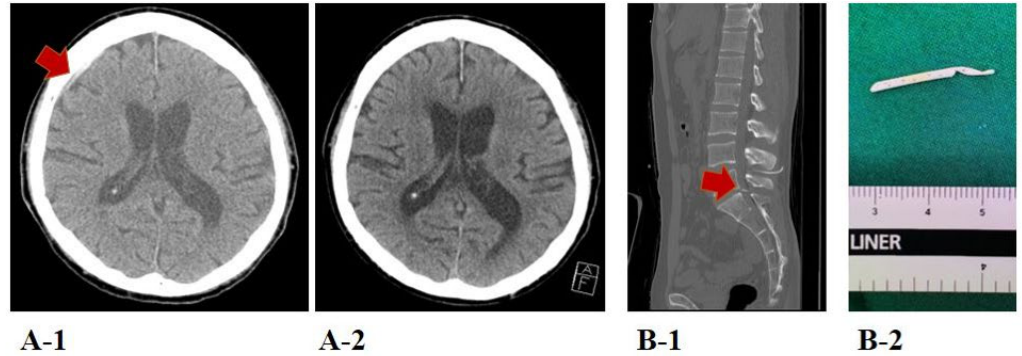
Figure 3. Adverse events during lumbar catheter placement. A 72-year-old female patient was found to have a new subdural hematoma in the right frontal area (red arrow) on a brain computed tomography (CT) scan ( A-1 ) taken after targeted temperature management (TTM), which had disappeared on a follow-up brain CT scan ( A-2 ) taken 2 weeks later. A 38-year-old male patient had a new residual lumbar catheter tip (red arrow) at the level of S1 on lumbar CT scan ( B-1 ) taken before TTM, which was surgically removed 12 days later ( B-2 ).